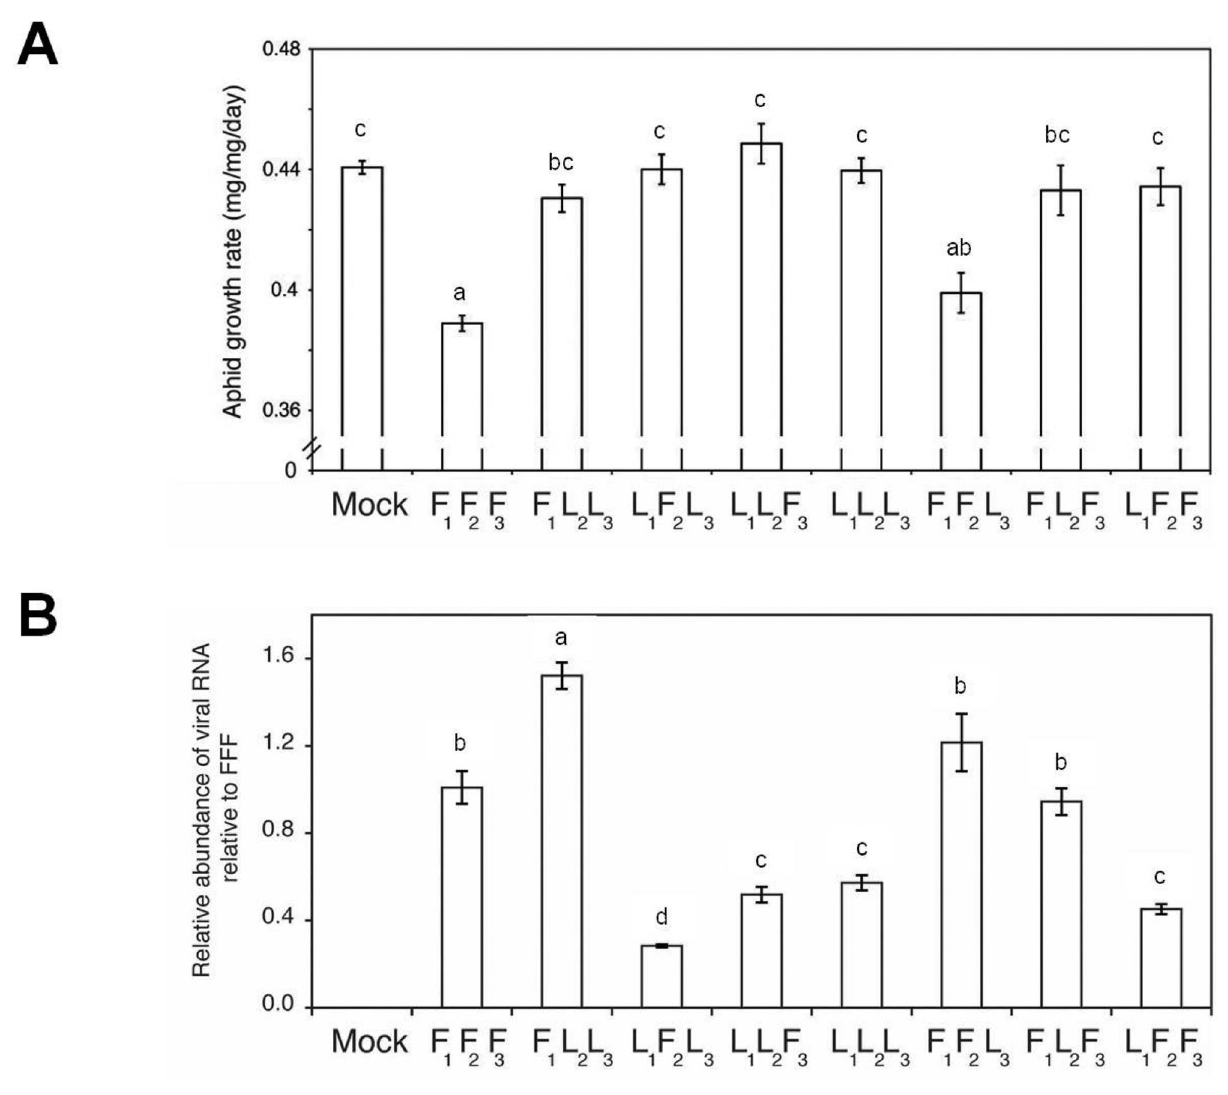
Figure 6. Virus-induced anti-aphid resistance mapped to Fny-CMV RNA2. (A) Growth rate of individual aphids on plants infected with reassortant versions of CMV, n≥24. (B) Accumulation of viral RNA measured by RT-Q-PCR relative to the accumulation of Fny-CMV (F F F ) at 14 days post-inoculation. Viral reassortants generated using combinations of CMV genomic 1 2 3 RNAs 1, 2 or 3 (subscript numbering) of either Fny-CMV (indicated by F) or LS-CMV (L) were used to inoculate wild-type Arabidopsis plants (Col-0 ecotype). Mock indicates a mock-inoculated plant. Different letters (a-d) are assigned to statistically different results (ANOVA with post-hoc Tukey’s tests, P <0.05). Error bars represent standard error of the mean.